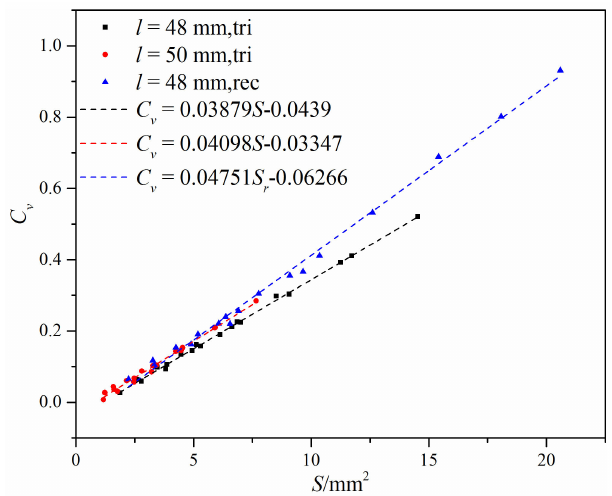
Figure 13. The flow coefficient under different flow cross-areas and different gap